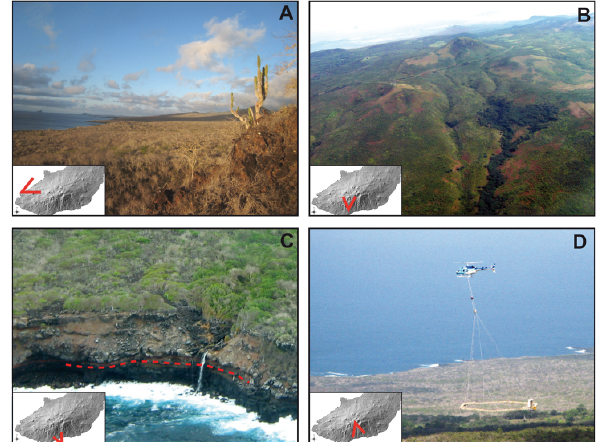
Fig. 3. Photographs of the southern shield of San Crist´obal Island. (A) The dry leeward slopes covered by shrubs and cactus. (B) San Joaquin volcanic cone, the topography is incised by streams fed by springs. (C) Perched stream over a red “baked” soil layer (under- lined with a red dashed line). (D) The helicopter carrying a frame with the SkyTEM transmitter and receiver coils. Photographs GI- IWS